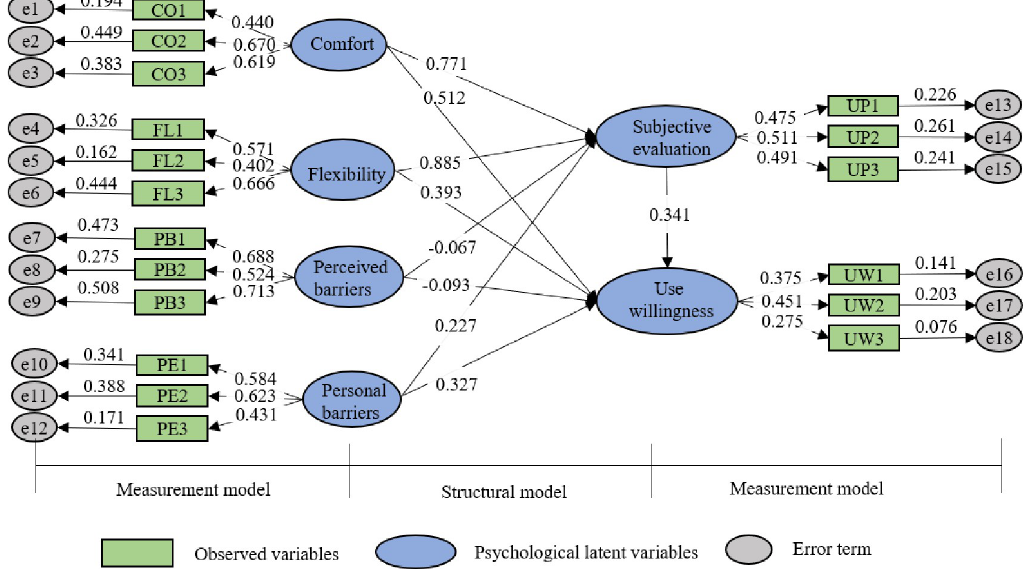
Fig 2. Estimation results between psychological latent variables and observed